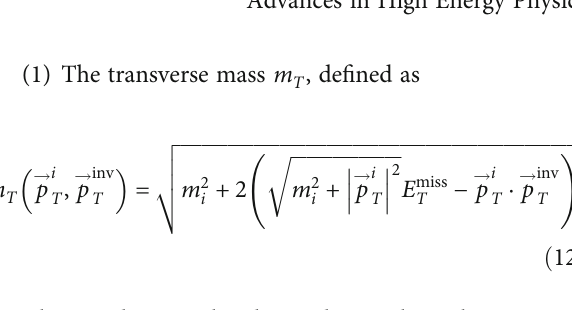
(1) The transverse mass m